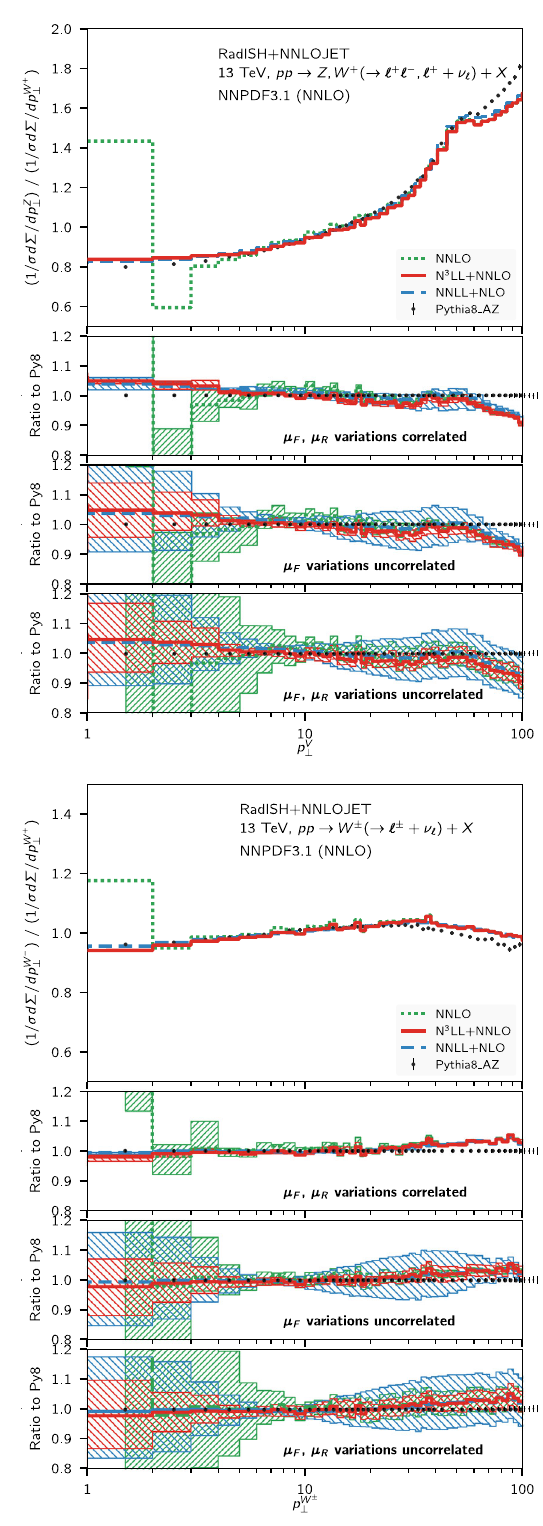
Fig. 4 Ratios of Z / W + and W − / W + normalised differential distri- Fig. 5 Ratios of Z / W + and W − / W + normalised differential dis- butions at NLL+LO (green, dotted), NNLL+NLO (blue, dashed) and tributions at NNLO (green, dotted), NNLL+NLO (blue, dashed) and √ √ s = 13 TeV. The three lower pan- s = 13 TeV. For reference, the N 3 LL+NNLO (red, solid) at N 3 LL+NNLO (red, solid) at Pythia8 prediction in the AZ tune is also shown, and the lower panels els show three different prescriptions for the theory uncertainty, as described in the text show the ratio of each prediction to the